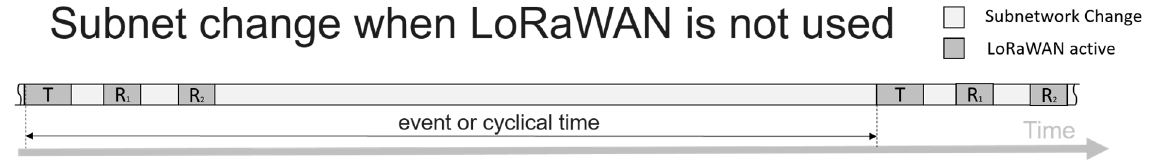
Figure 5. LoRaWAN vs. Short Lora transmission intervals.